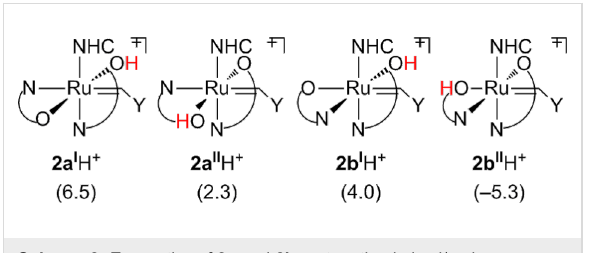
energy of the proton we assumed the value of − 262.2 kcal/mol from the literature [51,52]. It is assumed that the protonated Ru species remains in the organic phase. The energetics for the four oxygen protonated species of 2a and 2b is reported in Scheme